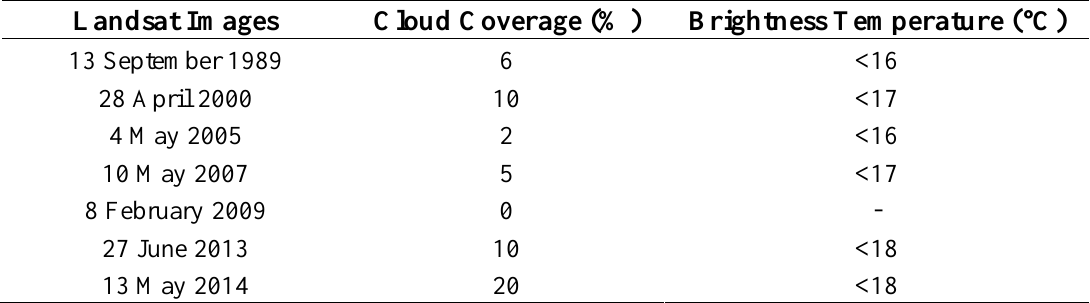
Table 1. Cloud coverage and brightness temperature threshold values used to mask out clouds in Landsat